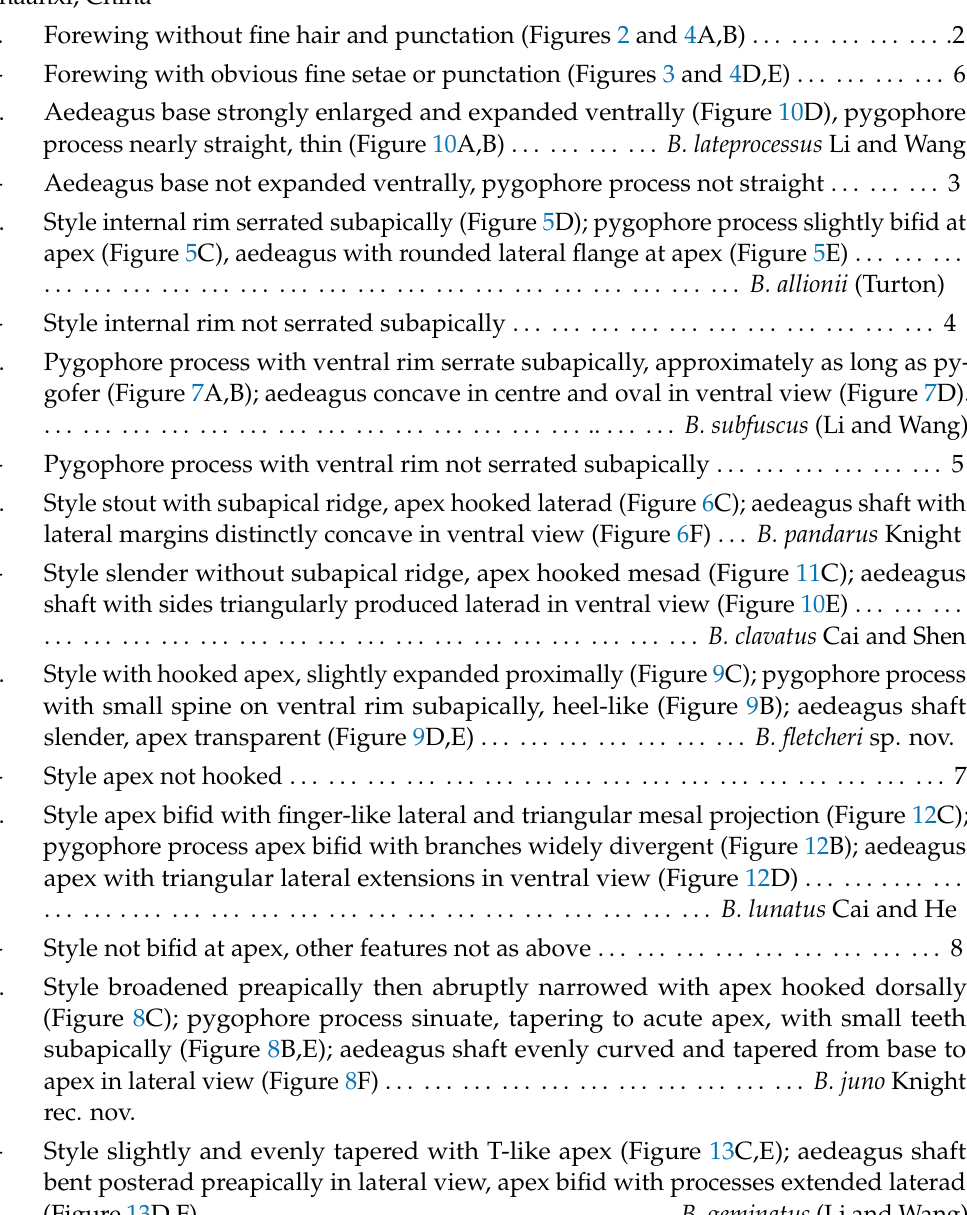
Forewing with obvious fine setae or punctation (Figures 3 and 4D,E) . . . . . . . . . . . . 6 2. Aedeagus base strongly enlarged and expanded ventrally (Figure 10D), pygophore process nearly straight, thin (Figure 10A,B) . . . . . . . . . . . . B. lateprocessus Li and Wang Aedeagus base not expanded ventrally, pygophore process not straight . . . . . . . . . 3 3. Style internal rim serrated subapically (Figure 5D); pygophore process slightly bifid at apex (Figure 5C), aedeagus with rounded lateral flange at apex (Figure 5E) . . . . . . . . .